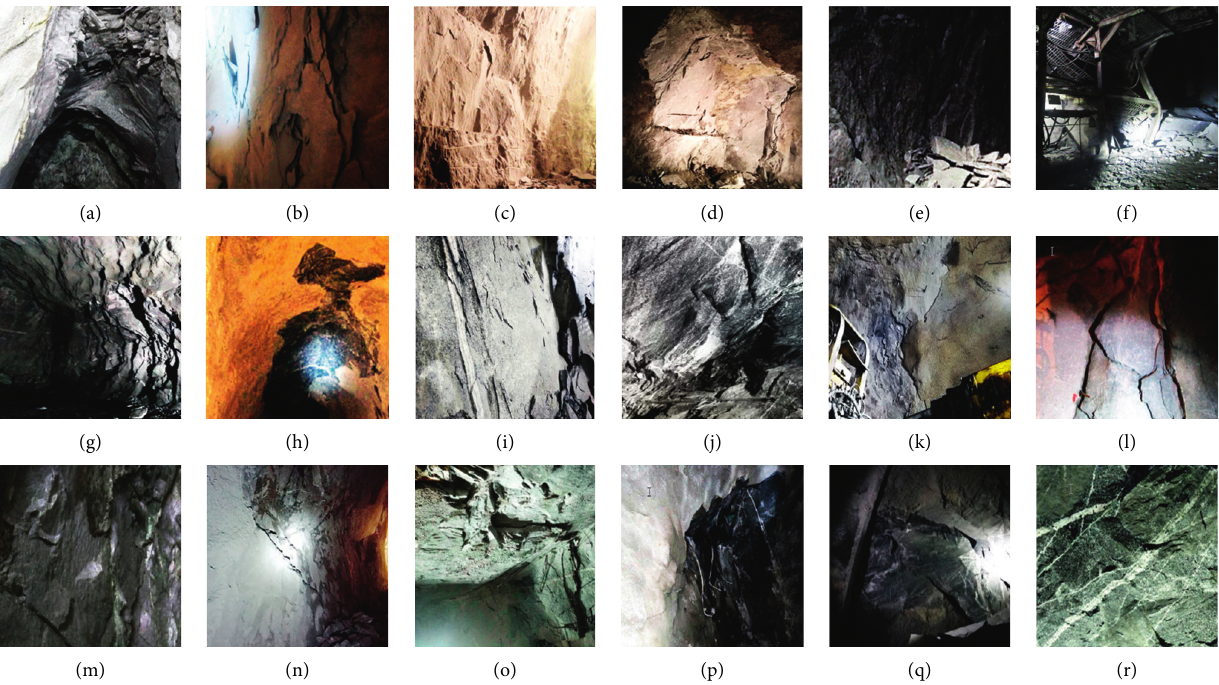
Figure 5: Appearances after rock bursts at different measurement locations. (a) Point 1. (b) Point 2. (c) Point 3. (d) Point 4. (e) Point 5. (f) Point 6. (g) Point 7. (h) Point 8. (i) Point 9. (j) Point 10. (k) Point 11. (l) Point 12. (m) Point 13. (n) Point 14. (o) Point 15. (p) Point 16. (q) Point17. (r) Point 18. Table 2: Field rock burst grades at different measurement points. No. of measurement